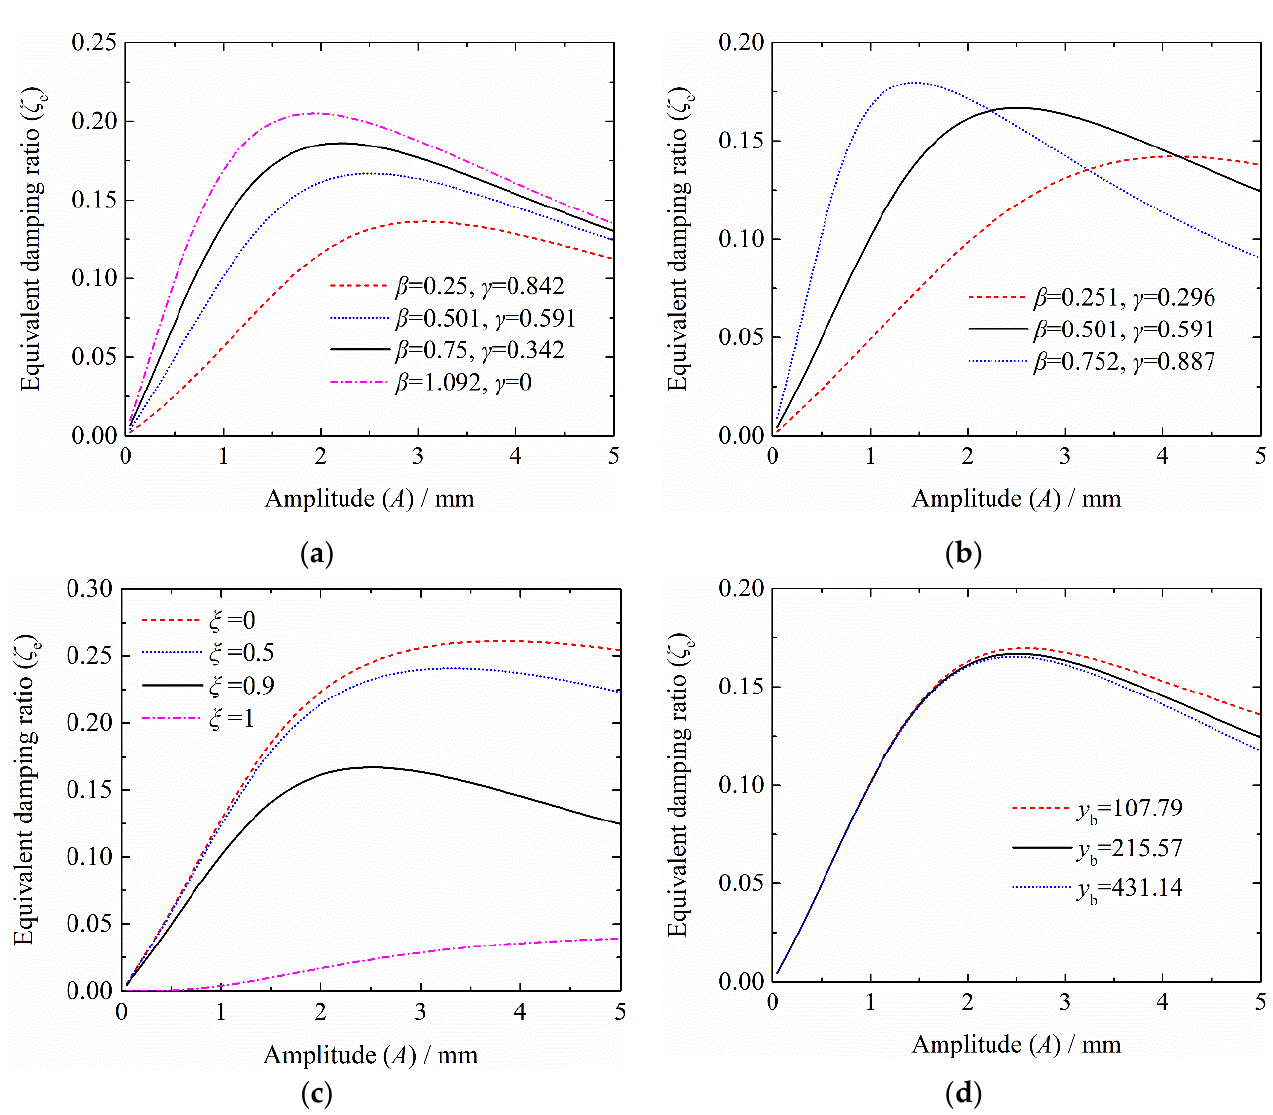
Figure 5. The generalized equivalent damping ratio of the isolator with different ( a ) Bouc–Wen model parameters ( β / γ ), ( b ) Bouc–Wen model parameters ( β + γ ), ( c ) pinching parameters ξ , and ( d ) pinching parameters y b .